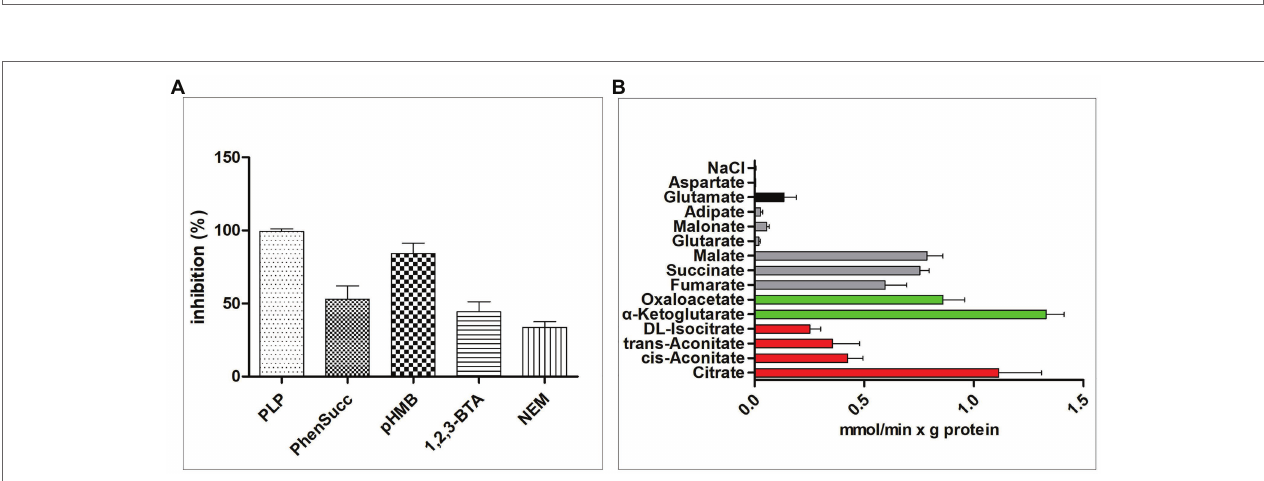
FIGURE 3 | Scanning electron microscopy examination of liposome. (A) The red arrow indicates the liposome. (B) The green arrow indicates the liposome after CT